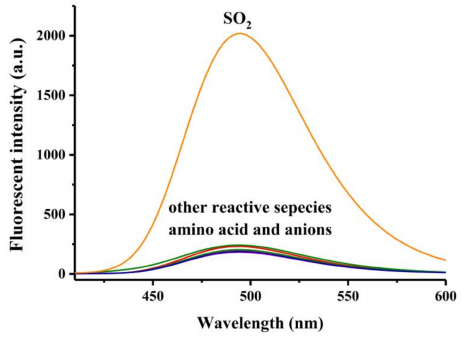
Figure 4. Fluorescence spectrum changes of BPO-Py-Cl (10 µ M) interacting with 500 µ M amino acids (Arg, Met, Ser, Asp, Gly, Ala, His, Val, Lys, Leu, Glu, Pro, Ile, Phe), reactive oxygen species (H 2 O 2 , NaClO, TBHP), reactive nitrogen species (NO 3 − , NO 2 − ), and reactive sulphur species (SO 4 2 − , Cys, Hcy, GSH, H 2 S, SO 2 ) in 10 mM pH 6.0 PBS buffer solution containing 20% DMSO, λ ex = 390 nm. Slit: 2.5 nm/5